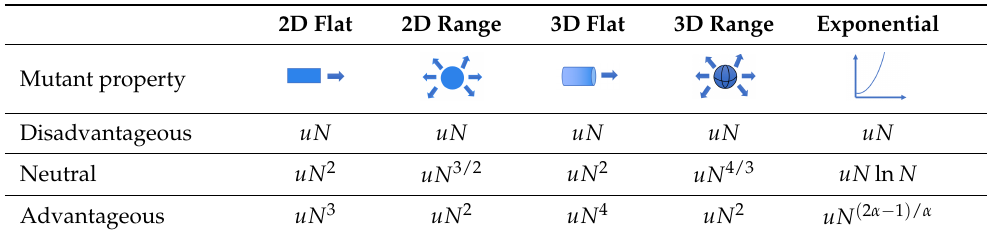
Table 2. Mutant scaling laws for expanding populations; see [19]. Here, N is the population size, u is the mutation rate, and α > 1. See text for details. 2D Flat 2D Range 3D Flat 3D Range Exponential Mutant property Disadvantageous